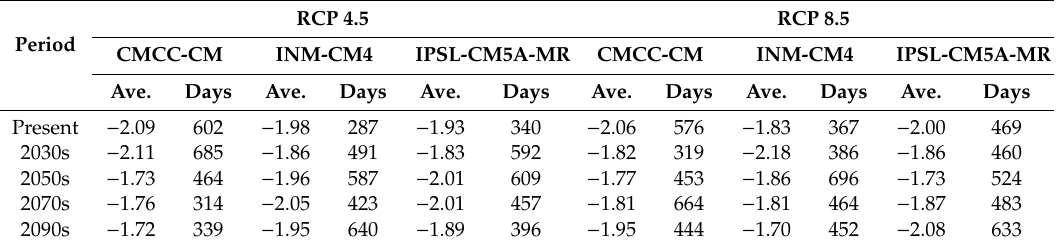
Table 5. The average value below − 1.5 of SPI-6 and the count days during each period for present and future periods.